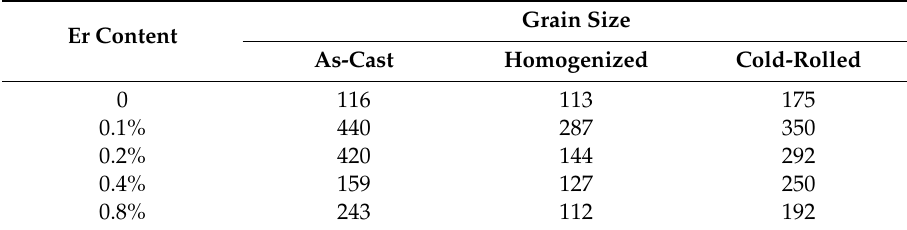
Table 4. Grain size of 5052 aluminum alloys ( µ